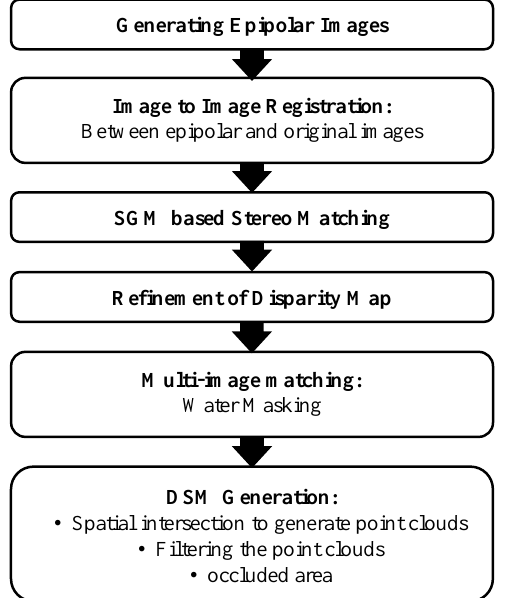
Figure 1. The Workflow of the DSM generation